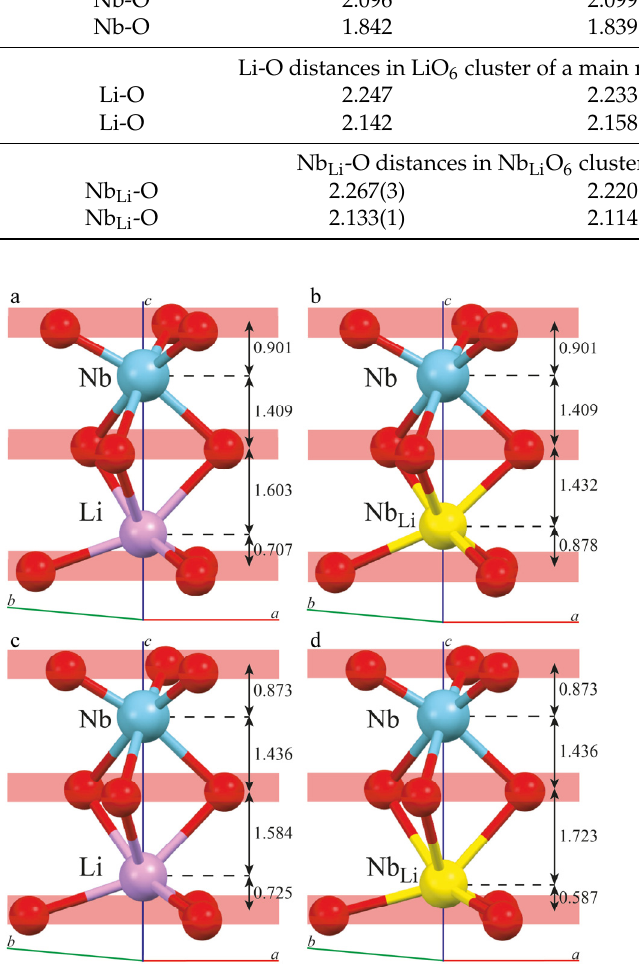
Figure 7. Location of cations in oxygen–octahedra clusters Ме O 6 in oxygen planes in crystals: ( a , b )—sample 1; ( c , d )—sample 2. ( a , b )—sample 1; ( c , d )—sample